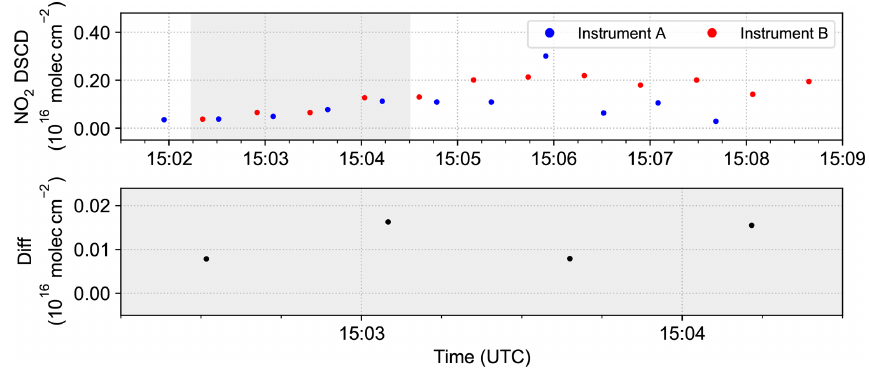
Figure 2. Time series of the NO 2 results for the 90 ◦ measurements of both instruments on the upwind side. The spectra are analysed using the first 90 ◦ spectrum as a reference. The shaded grey area denotes the range where both measured similar NO 2 DSCDs. In the lower panel the difference between the two Tube MAX-DOAS instruments is depicted, zoomed into the shaded grey